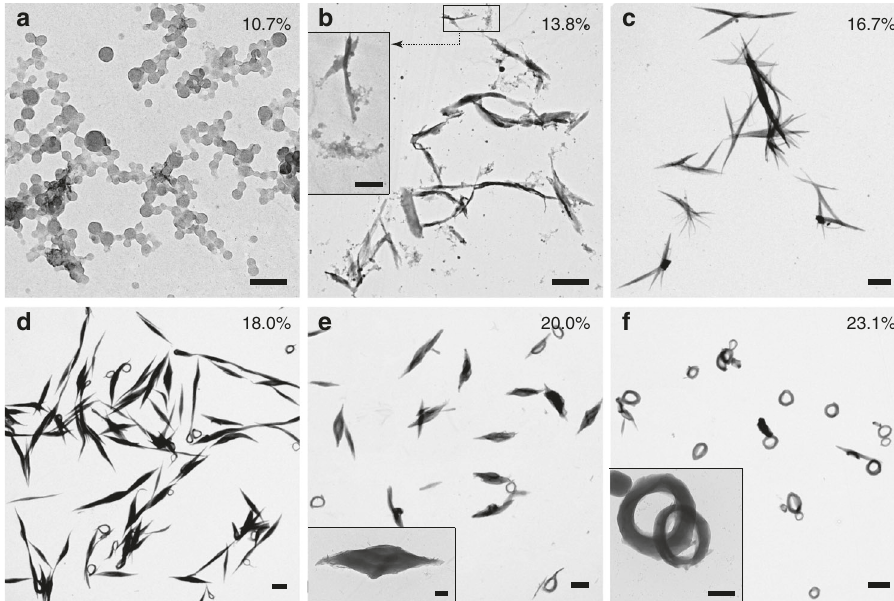
Fig. 4 Effect of water content on the self-assembly of PS- b -PDLA. TEM images of representative structures formed in THF/water mixtures with varied water content ( f water ): a 10.7%, b 13.8%, c 16.7%, d 18.0%, e 20.0%, and f 23.1%. The insets in ( b ) and ( e ) are higher-magni fi ed images of structures formed and inset in ( f ) is a Rused ring-like assembly observed very occasional on the grid. Scale bars: 200 nm in ( a ); 2 μ m in ( b – f ); 500 nm in